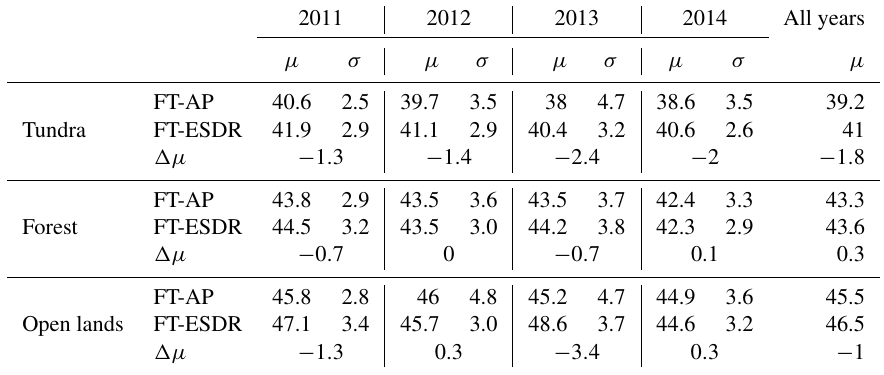
Table 3. Mean ( µ ), standard deviation ( σ ) and mean difference ( (cid:49)µ ) between products of freeze onset date (week of the year) for each land cover.